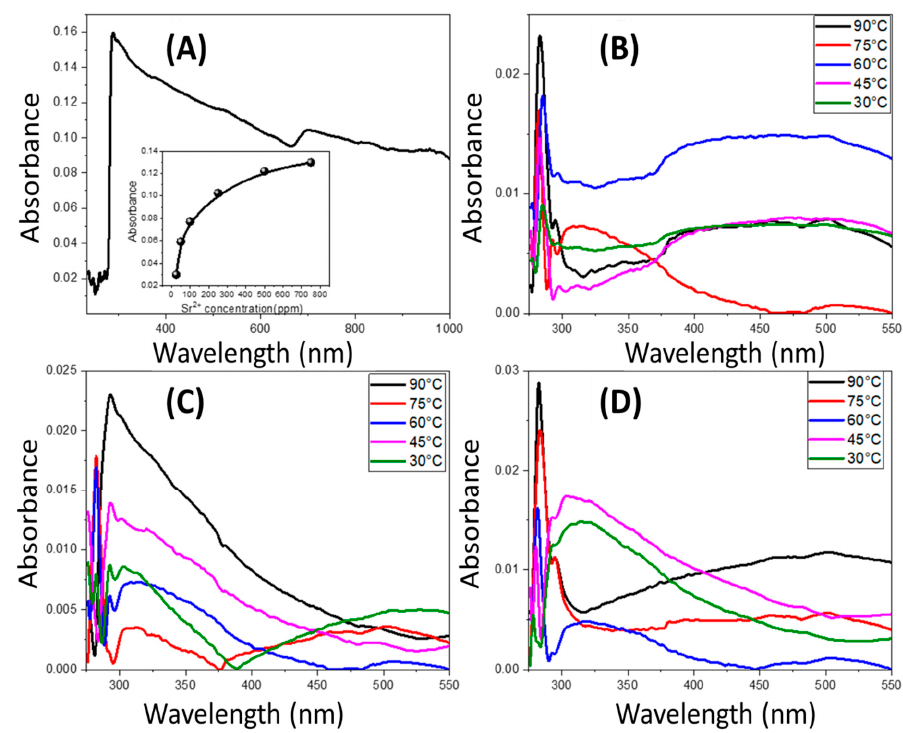
Figure 7. ( A ) Absorbance spectra of 100 ppm Sr 2+ aqueous standard solution, and ( B – D ) absorbance spectra of permeate after filtration using 0.1, 0.5, and 0.7 PES/TNR-MWCNTS membranes, respec- tively. The inset of ( A ) shows absorbance values versus the strontium concentration at 289 nm. Table 2. Values of the maximum absorbance and filtration efficiency for 100 ppm Sr 2+ aqueous so- lutions at different temperatures using 0.1, 0.5, and 0.7 PES/TNR-MWCNT membranes.